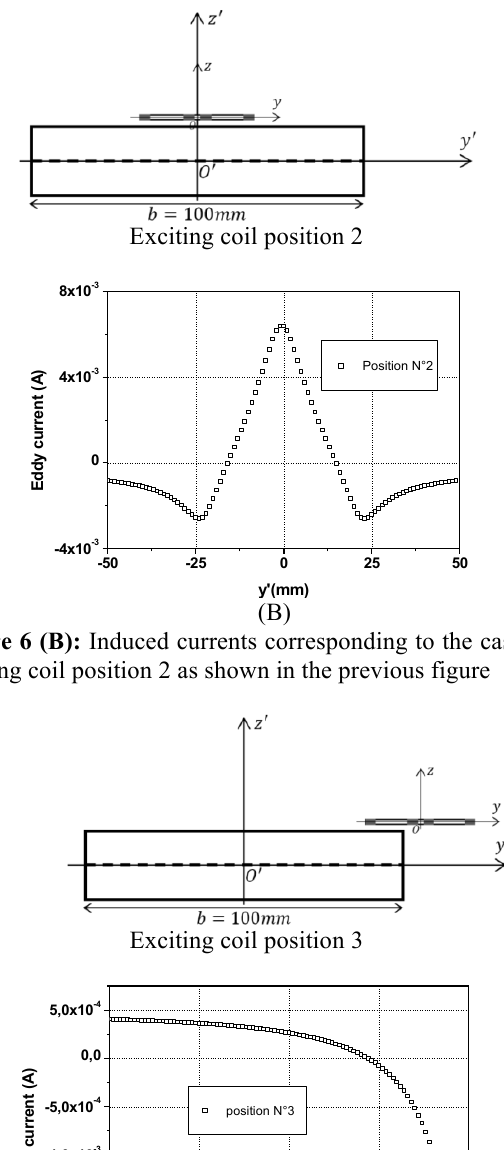
Exciting coil position 3